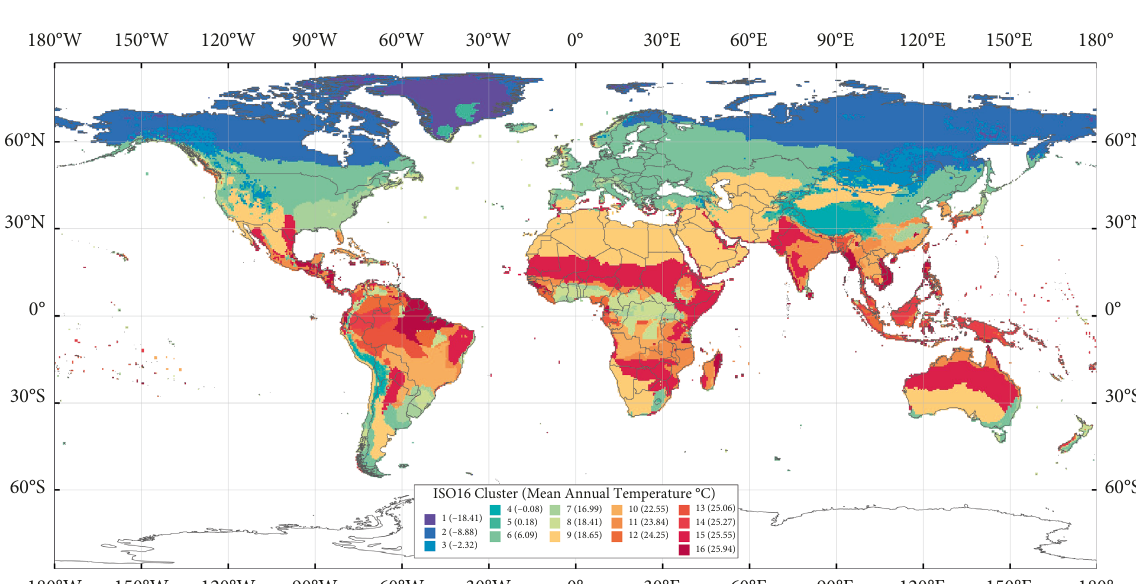
Figure 7: 30-cluster solution (KM30) of k -means clustering.